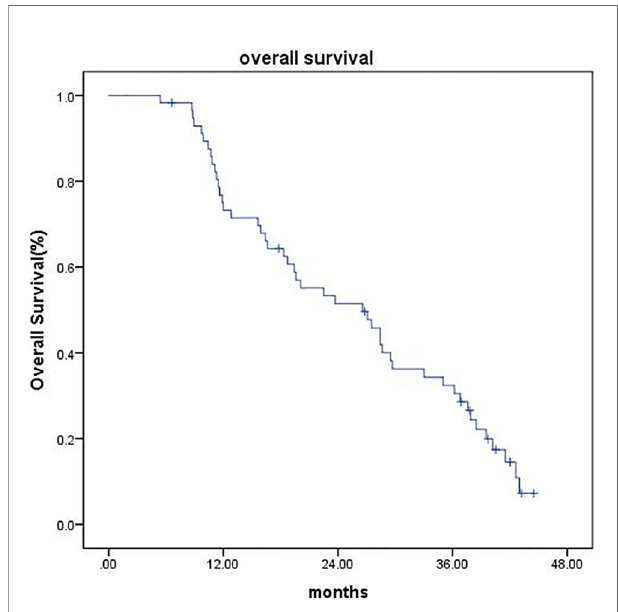
FIGURE 2 | Kaplan – Meier estimates of OS.